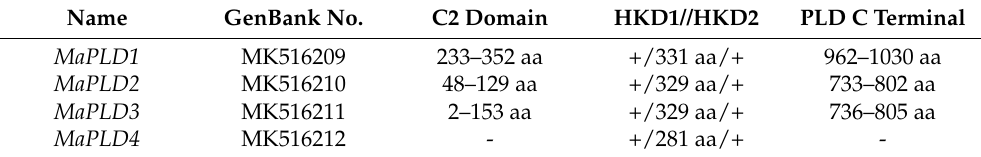
Table 1. The information of four MaPLD genes in